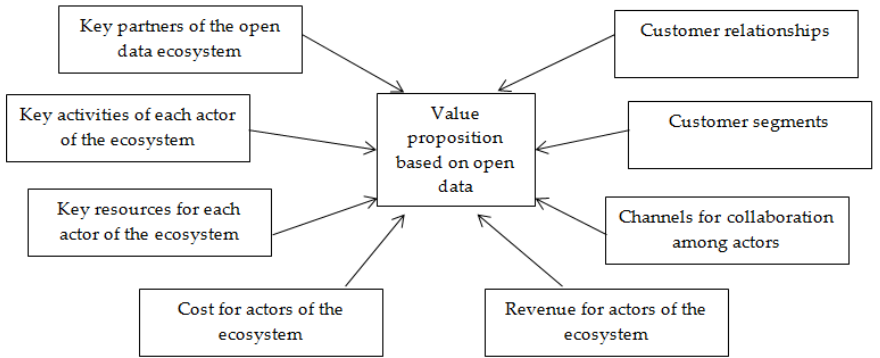
Figure 3. The categorization of the results.